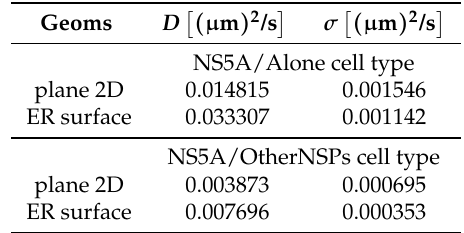
Table 1. Averaged final NS5A diffusion constant D ns5a as described in Section 3.7. The final values are computed by means of the averaging process of the single results (as described in Section 2.7) which was shown graphically within Figure 7. We give results for the case of the use of the ER geometry setups as described in Sections 3.1 and 3.2, but also for a simplified classical 2D planar consideration, cf. Section